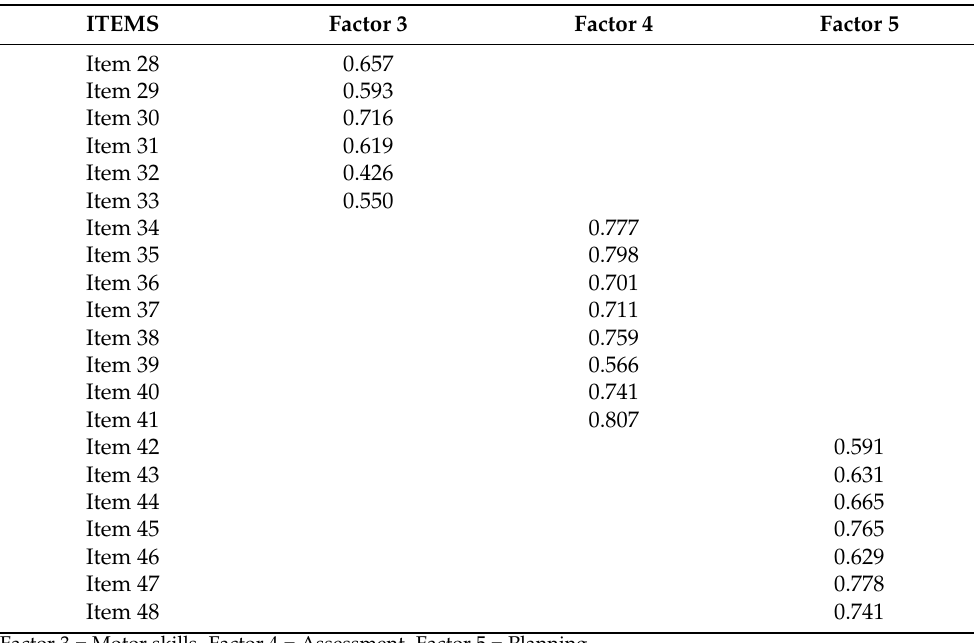
Table 2. Exploratory factorial analysis of the attitudinal